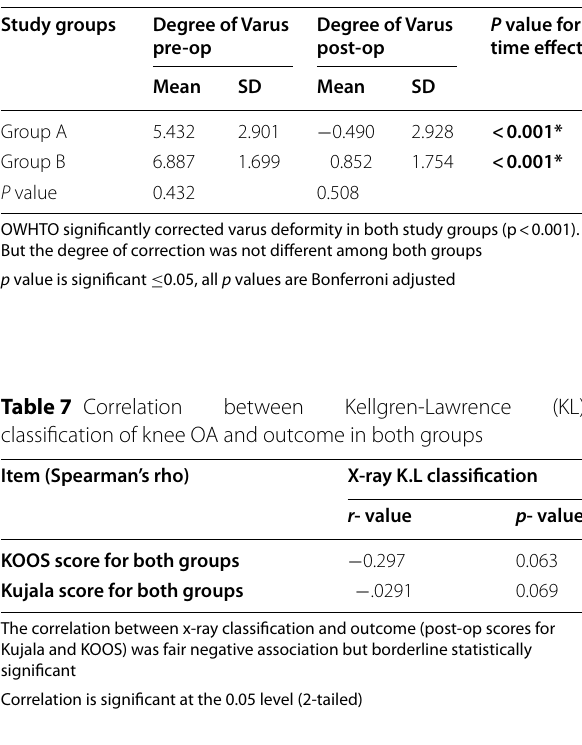
Table 6 Degree of varus malalignment before treatment and after treatment in both groups